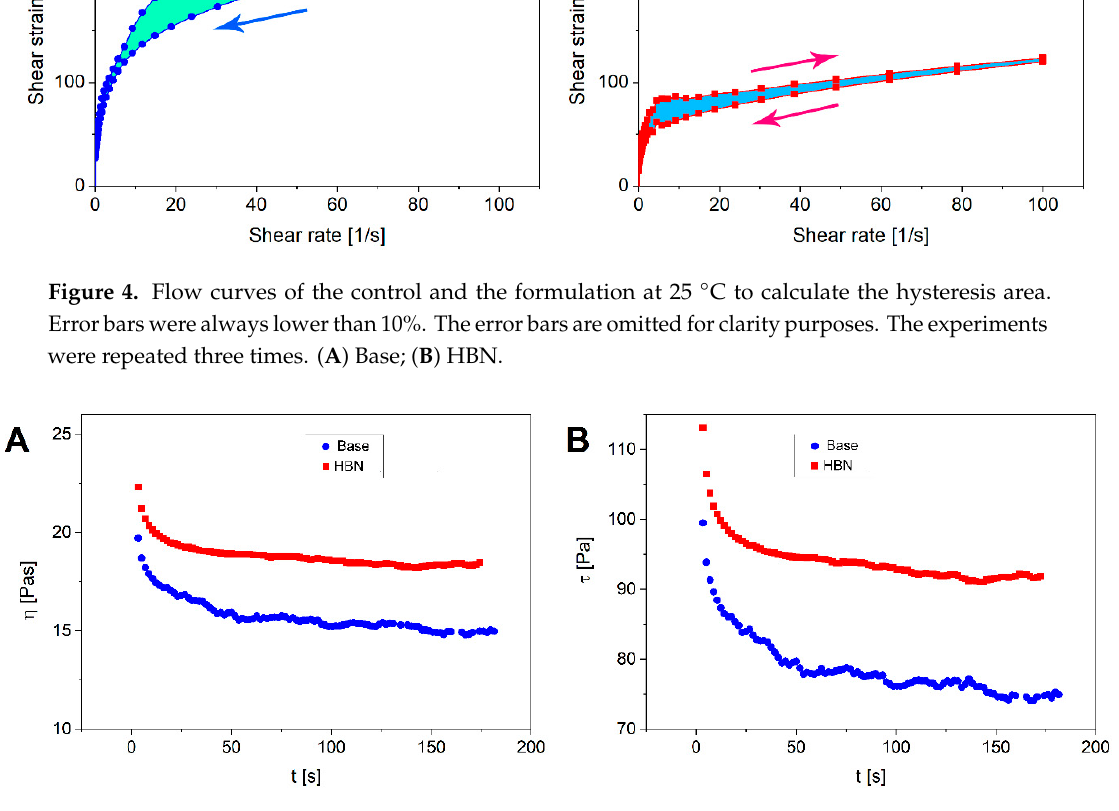
Figure 4. Flow curves of the control and the formulation at 25 °C to calculate the hysteresis area. Error bars were always lower than 10%. The error bars are omitted for clarity purposes. The experiments were repeated three times.